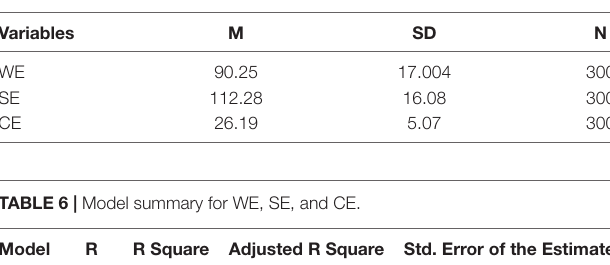
TABLE 5 | Descriptive statistics for WE, SE, and CE.